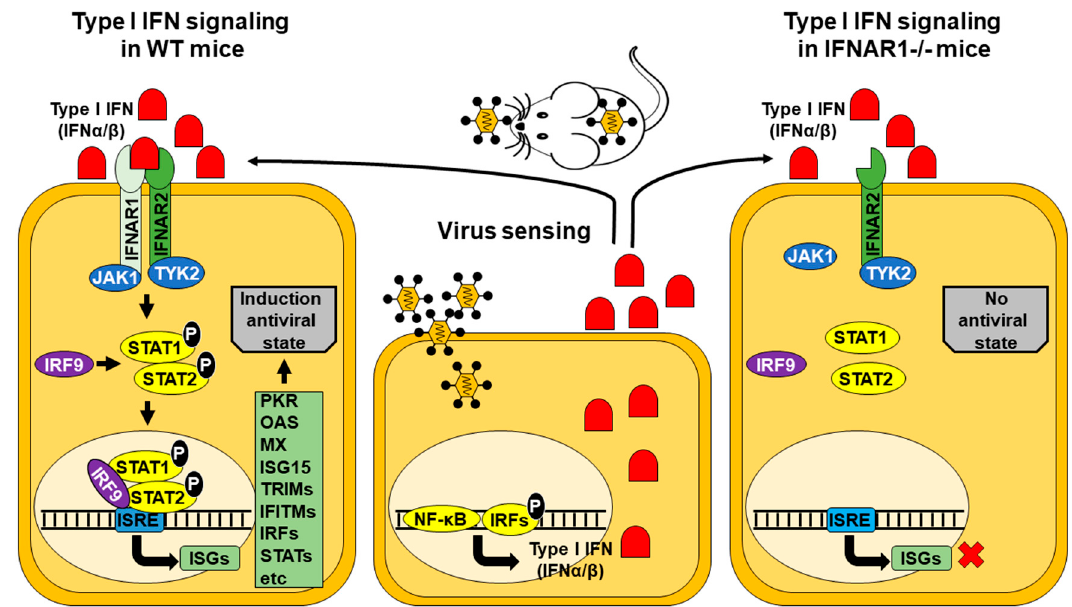
Figure 1. Signal transduction by the type I IFN receptors in wild-type (WT) or IFNAR − / − mice. Transcription of IFN genes is induced rapidly in response to viral infection. Cells sense viruses using multiple signaling pathways that ultimately will activate several transcription factors and their subsequent translocation into the nucleus, resulting in the activation of type I IFN (IFN α / β ) genes. In WT mice, the released type I IFN is bound by the specific receptors IFNAR1/IFNAR2 trigging phosphorylation of JAK1/TYK2 kinases that activate STAT1 and STAT2. Phosphorylated STAT1/STAT2 heterodimers bind IRF9 and the complex is translocated to the nucleus where it induces expression of ISGs with ISRE-dependent promoters. The expression of ISGs will induce an antiviral state to prevent viral infection. However, in IFNAR1 − / − mice, the antiviral state is not created, and cells are more susceptible to be infected. JAK, Janus activated kinase; TYK2, tyrosine kinase 2, ISRE, IFN-stimulated response element; ISG, IFN-stimulated gene; OAS, oligoadenylate synthetase; MX, myxovirus resistance; ISG15, IFN-stimulated gene factor 15; TRIM, tripartite motif-containing proteins; IFITM, IFN-induced transmembrane proteins; IRF, IFN-regulatory factors; STAT, signal transducer and activator of transcription; NF- κ B, nuclear factor of kappa light polypeptide gene enhancer in B-cells.